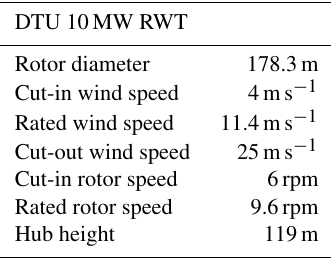
Table 2. The main characteristics of the reference wind